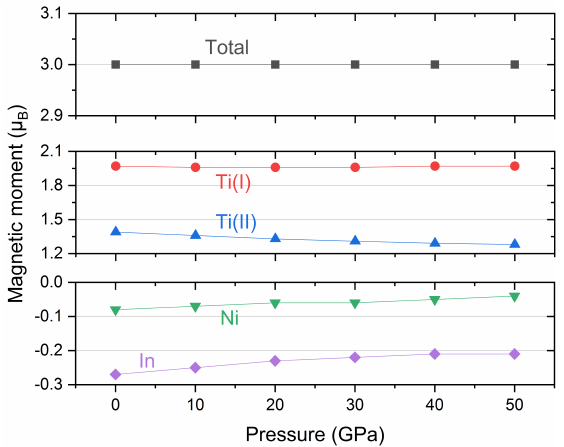
Figure 5. Total and atom-resolved magnetic momentum for Ti 2 NiIn compound under different pressure. Atomic site is referred as the inset crystal structure in Figure 1.